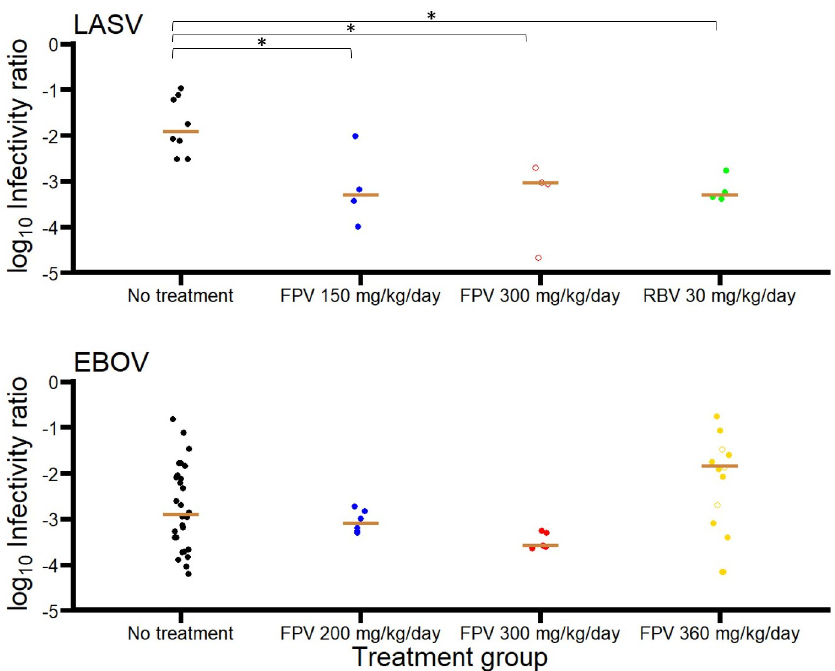
Fig 2. Ratio of titers to viral load at the time of peak viral load in cynomolgus macaques infected with Lassa (top) � � TCID 50 : mL (cid:0) 1 or Ebola (bottom) virus. The ratio of titers is given by log . Animals infected with Lassa virus were 10 RNAcopies : mL (cid:0) 1 either untreated (black), treated with FPV 150 mg/kg/day (blue) or 300 mg/kg/day (red), and treated with RBV (green). Similar ratio was calculated in animals infected with Ebola virus that were either untreated, treated with FPV 200 mg/kg/day (blue), FPV 300 mg/kg/day (red), or FPV 360 mg/kg/day. Empty circles correspond to undetectable viral titers imputed to the limit of detection (2 log 10 TCID 50 .mL -1 ). � = p < 0.05 (Wilcoxon